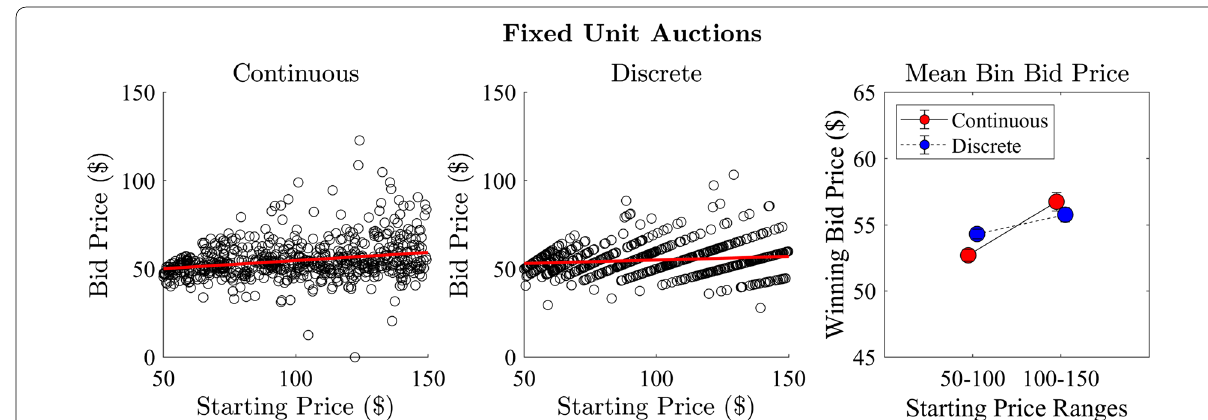
Fig. 8 Experiment 1: relationship between auction starting price and the price of the winning bid for continuous (left) and discrete (middle) step conditions and the mean price of the winning bid for auctions separated into high and low starting price (right)